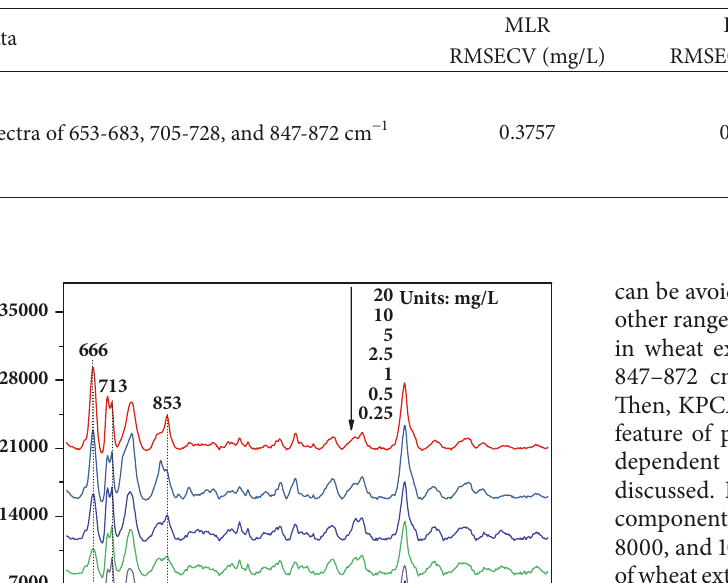
Table 1: Predicted results of the model developed using chemometric methods.